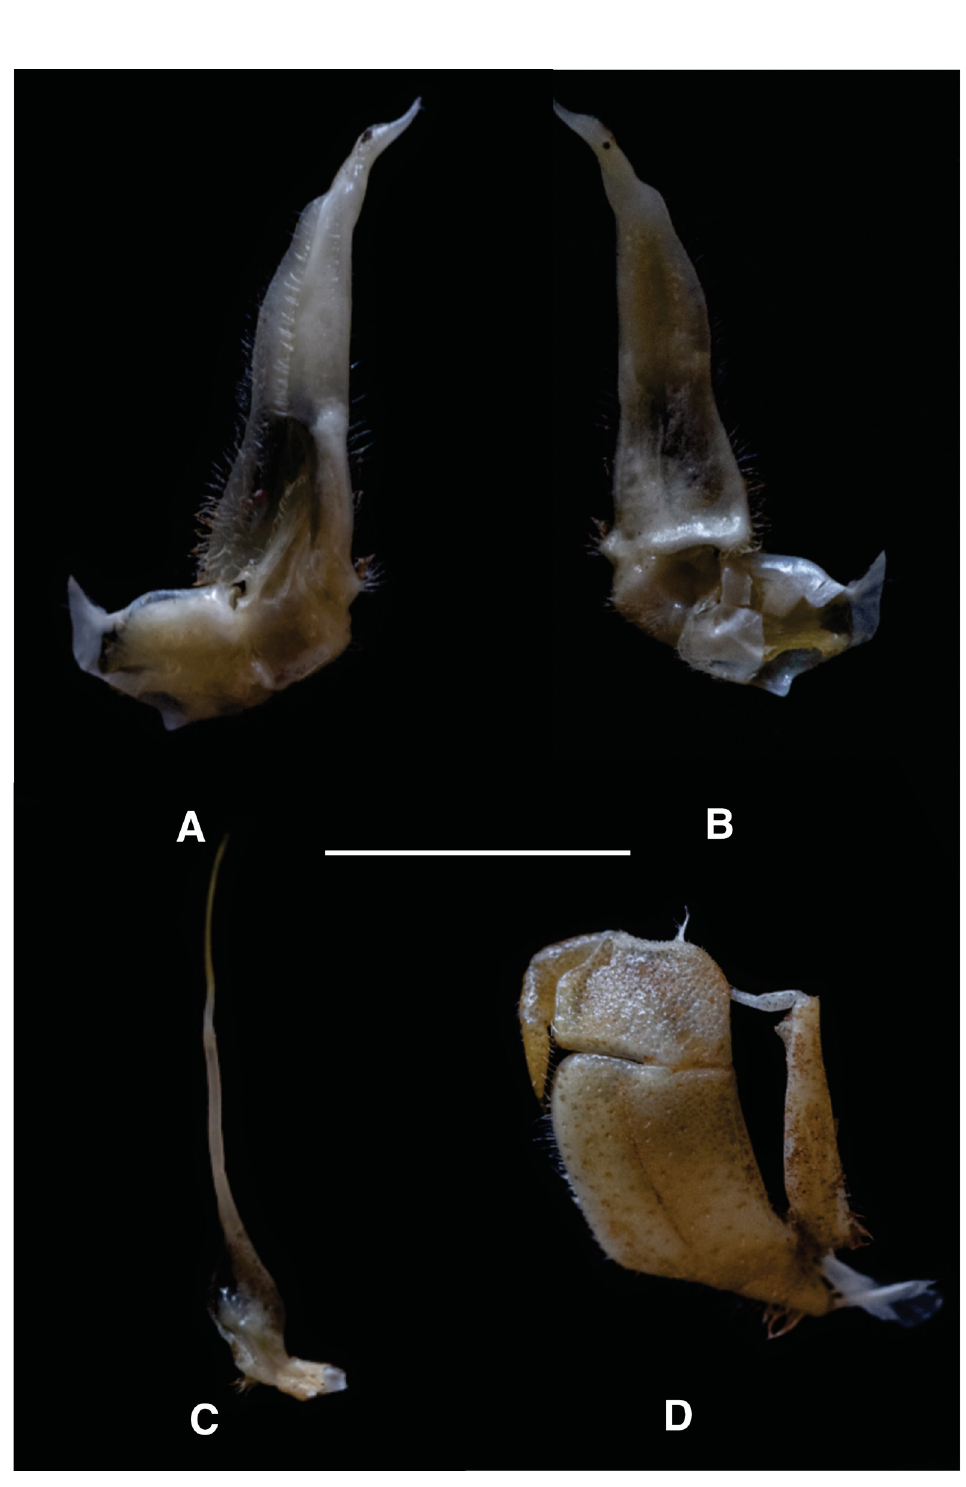
Fig. 3. Potamonautes mariepskoppie sp. nov., ♂, holotype (SAM A-094471) A . Left gonopod 1, anterior view. B . Left gonopod 1, posterior view. C . Left gonopod 2, anterior view. D . Right third maxilliped. Scale bar = 10